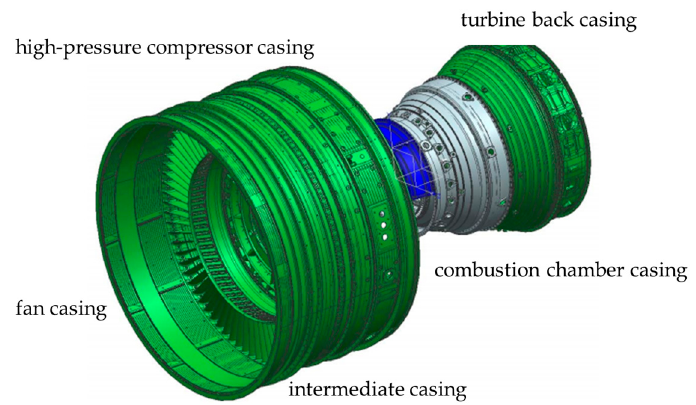
Figure 1. Three-dimensional model diagram of the whole casing for aero engine.